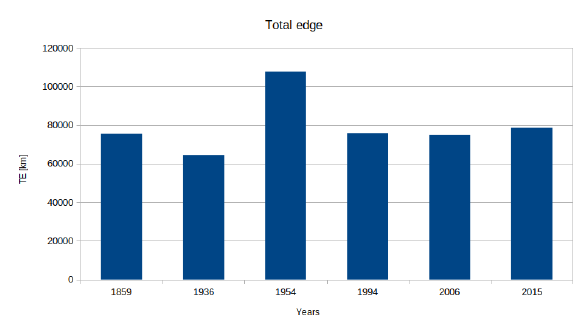
Figure 19. Total edge index for forest class change between 1859 and